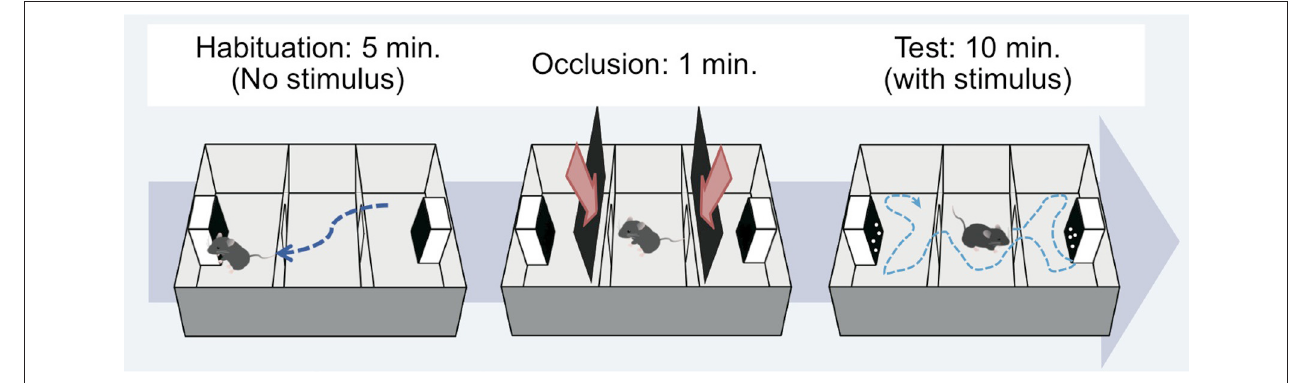
FIGURE 2 | Apparatus and procedure. Mice were tested by using a three-chambered apparatus (Moy et al., 2004). Habituation phase ( left ): the subject moved around freely for 5min to acclimate to the apparatus without any stimulus on the monitors. Occlusion phase ( middle ): the subject was placed in the central compartment for 1min to prepare for subsequent testing. Test phase ( right ): the doors to the side compartments were opened and the mouse again freely moved for 10min. Mouse movement during the experiments was recorded by web camera, and the time spent in each compartment was calculated using tracking